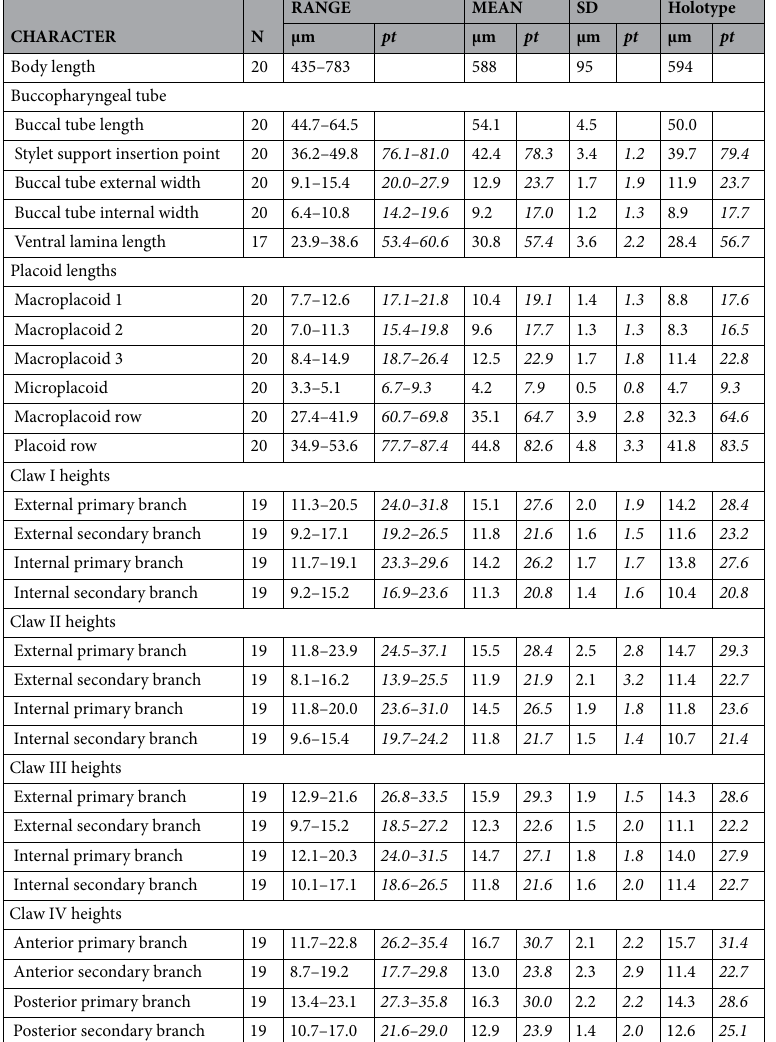
Table 2. Measurements [in µm] and pt values of selected morphological structures of individuals of Paramacrobiotus gadabouti sp. nov. mounted in Hoyer’s medium (N—number of specimens/structures measured; RANGE refers to the smallest and the largest structure among all measured specimens; SD— standard deviation, pt —ratio of the length of a given structure to the length of the buccal tube expressed as a percentage). pt values are in italic.